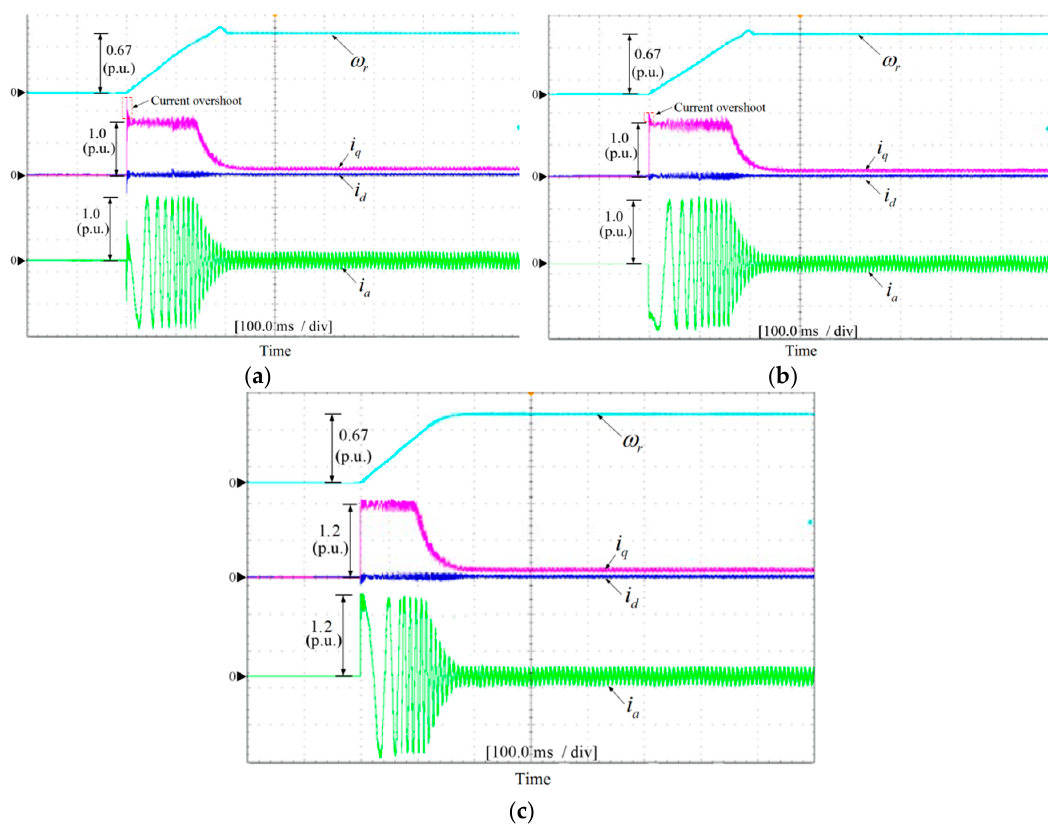
Figure 8. Experimental results of motor starting with appropriate parameters under no-load condition: ( a ) TBC; ( b ) AIBC_FP; ( c ) AIBC_AWPSO.